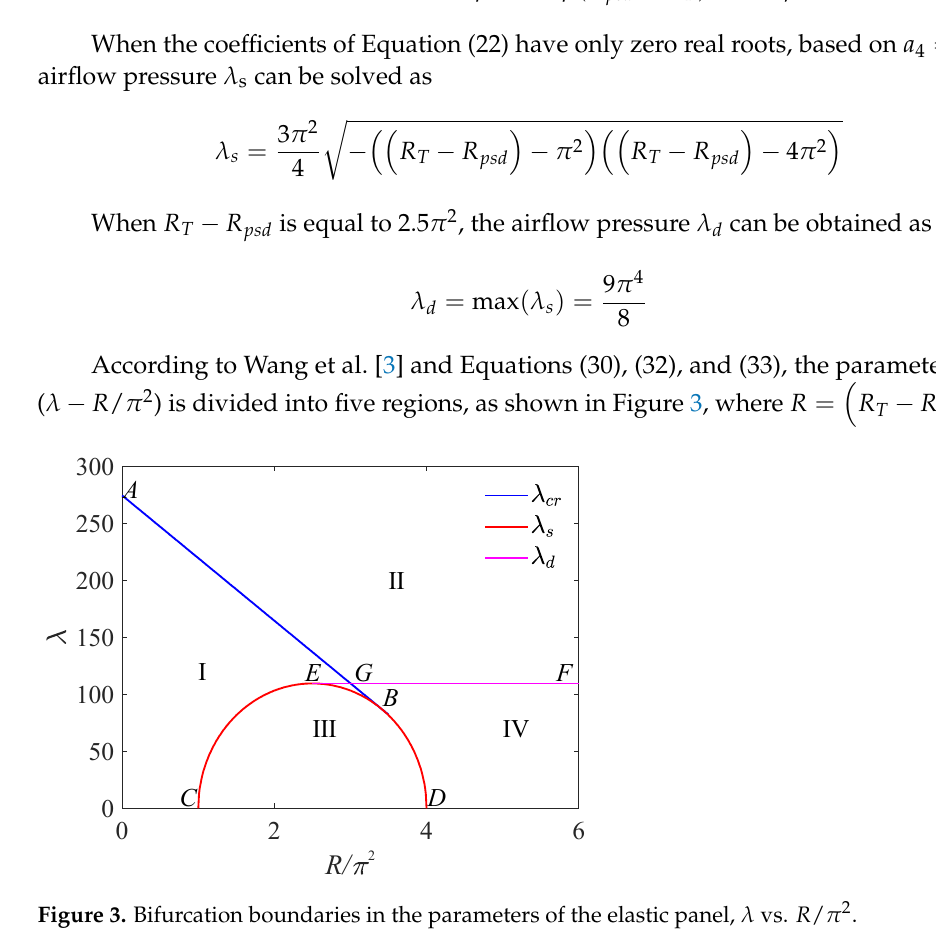
Figure 3. Bifurcation boundaries in the parameters of the elastic panel, λ vs. R / π 2 . When the airflow pressure λ is equal to λ s , Equation (27) has only one balance point X o ( 0, 0, 0, 0 ) . When the parameters are in regions EBG and IV of Figure 3, the equilibrium points of the panel change to five equilibrium points, and the additional equilibrium